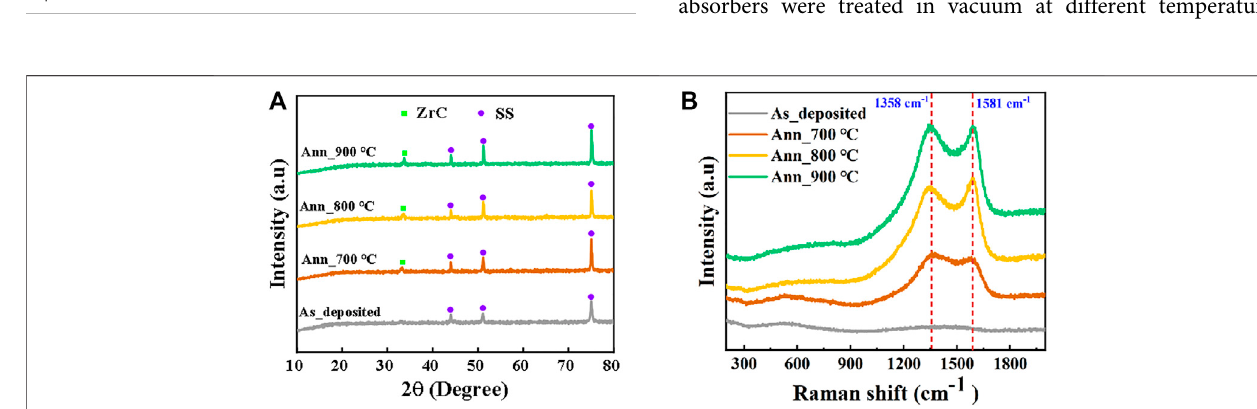
FIGURE 5 | XRD patterns (A) and Raman spectra (B) of CAA coatings deposited on stainless steel substrates before and after annealing at different temperatures in vacuum.